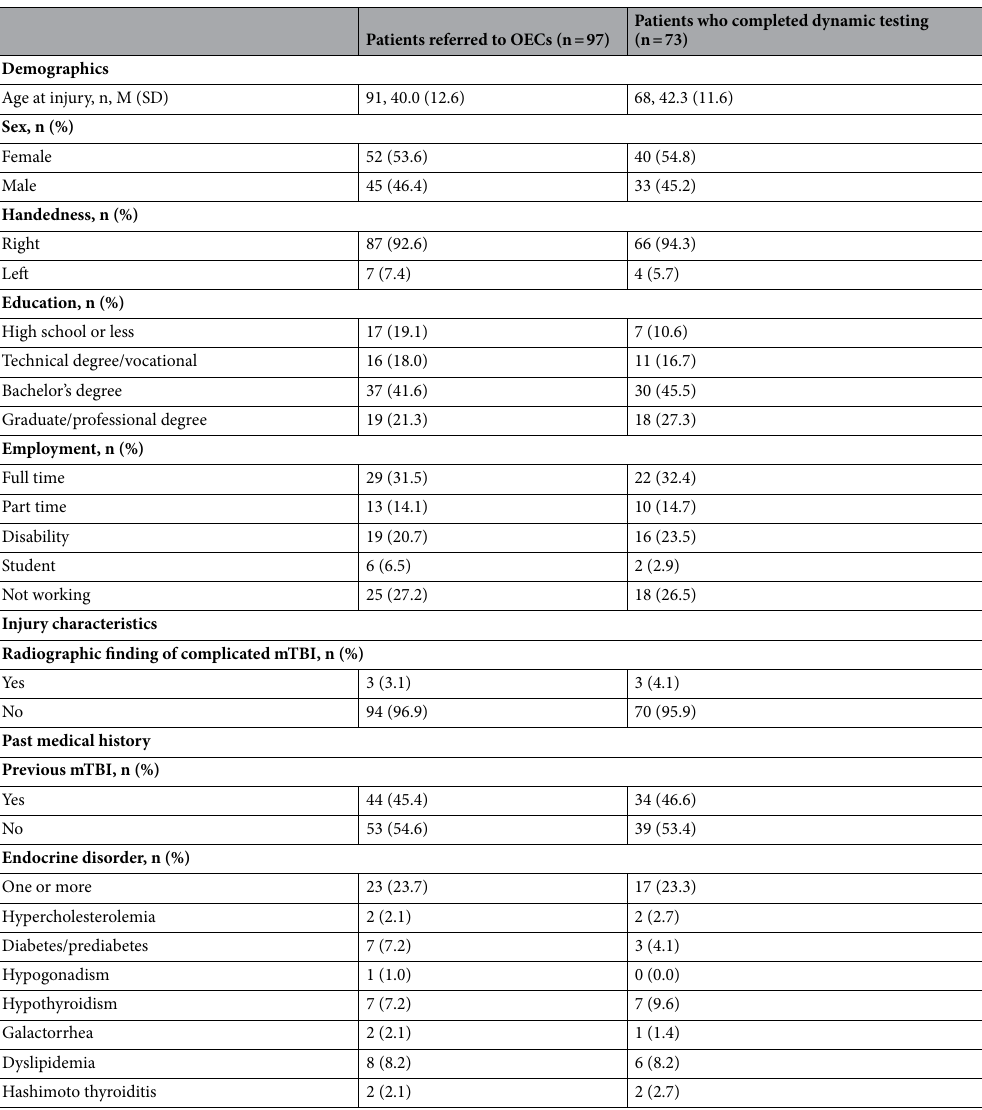
Table 1. Demographics and past medical history of patients referred to OECs and who completed dynamic testing. mTBI mild traumatic brain injury, OECs outpatient endocrinology